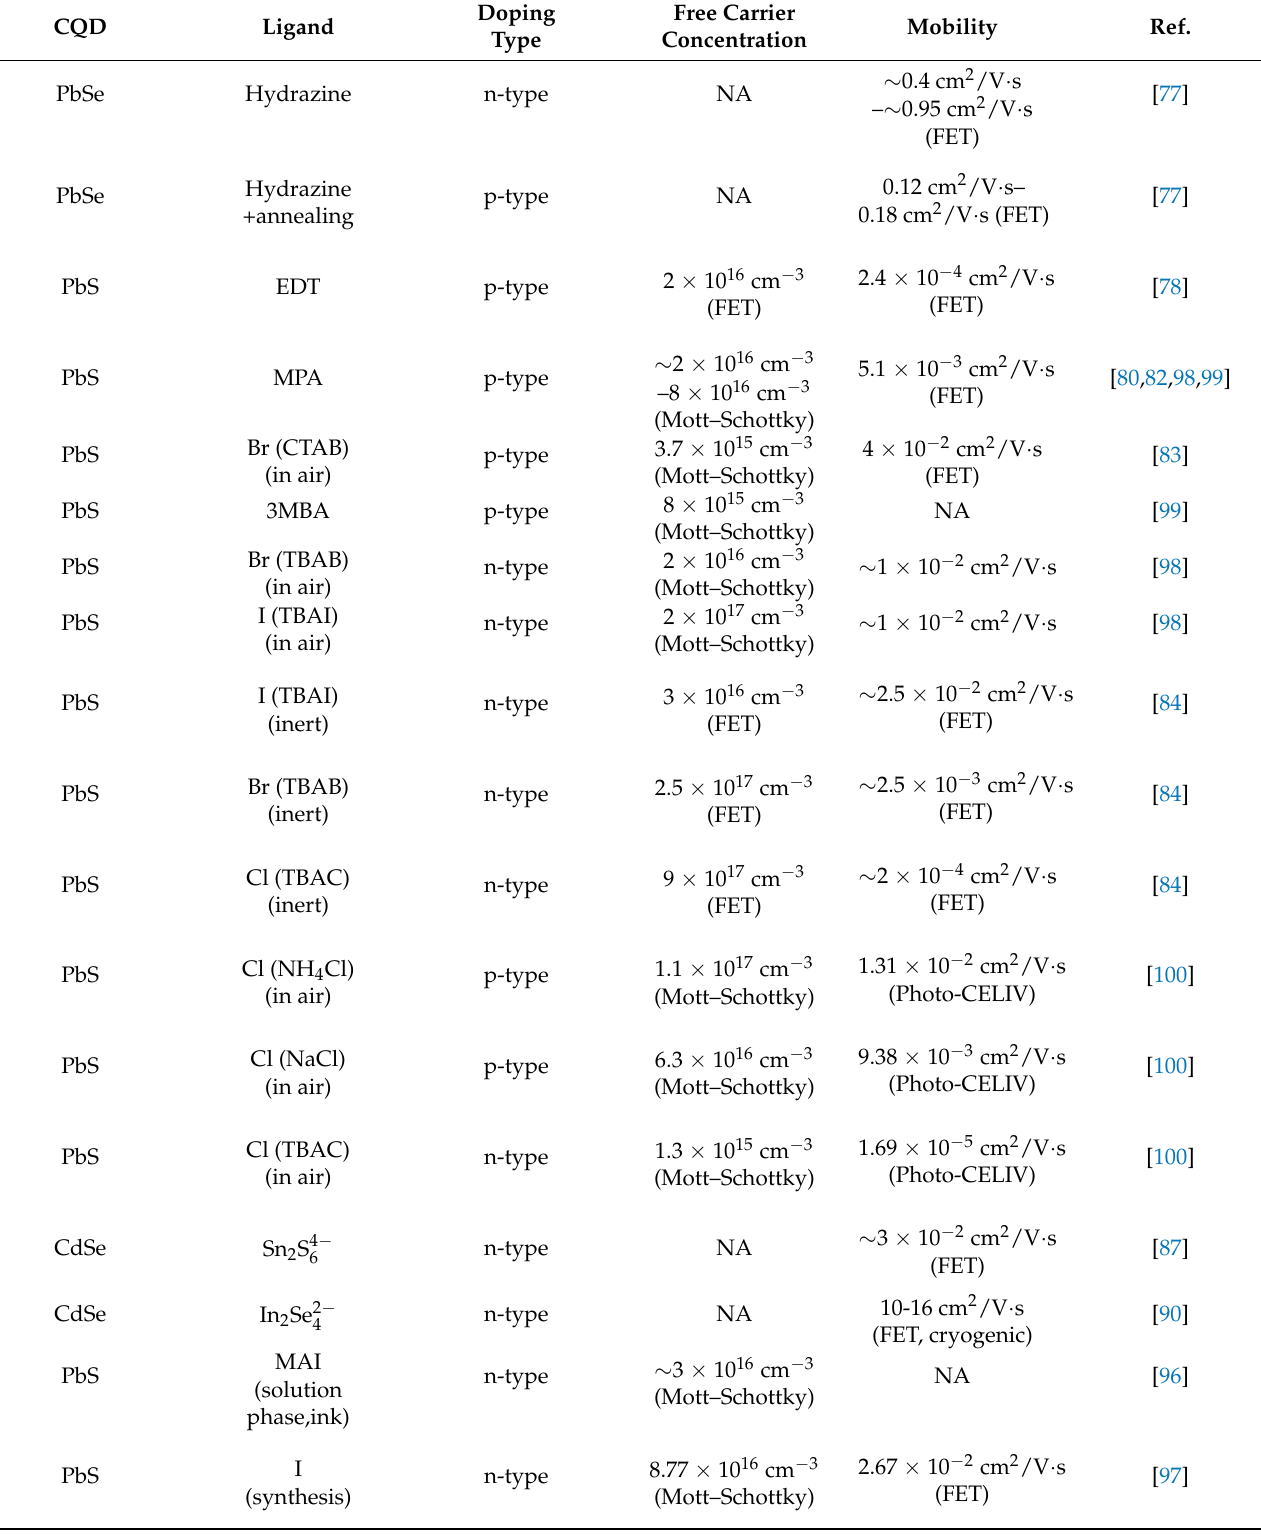
Table 4. Significant examples of the doping effect by ligand